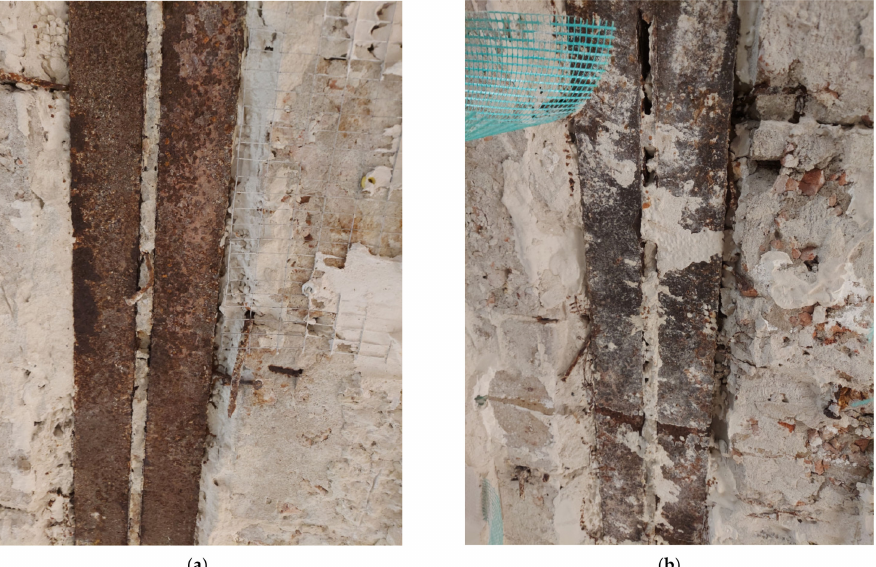
Figure 5. Technical condition of the bottom chord of the steel trusses: general view of the bottom chord of the steel trusses in different places ( a ) the finishing layer had no adhesion to the surface of the bottom chord; ( b ) the finishing layer had good adhesion to the surface of the bottom